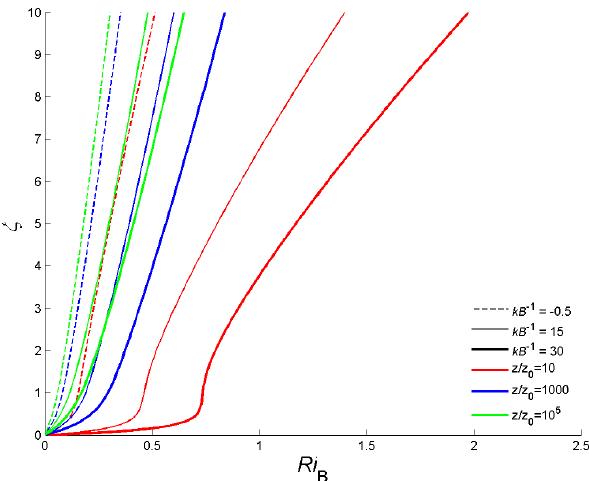
Fig. 1. The relationship between Ri B and ζ from the precise results of CB05.